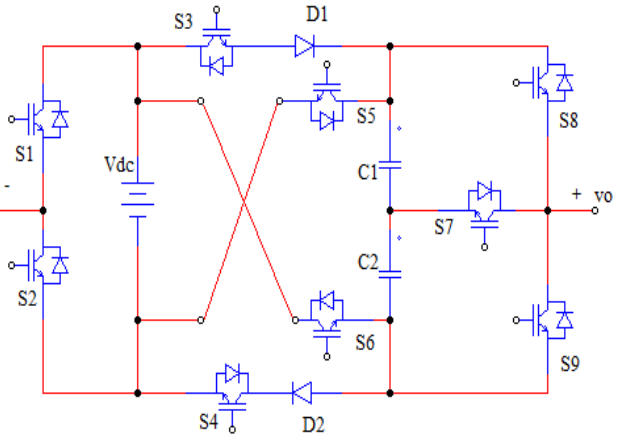
Figure 11. Nine-switch, nine-level topology [60] .